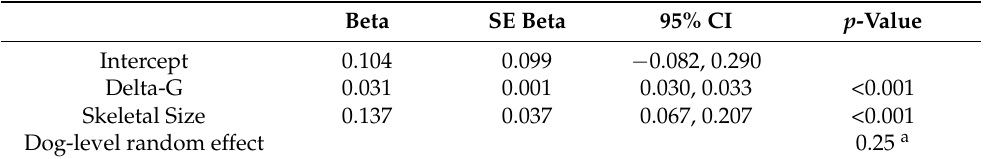
Table 2. Results from a mixed-effects linear regression model predicting speed with repeat measure- ments in individual dog accounted for with an intercept-only random effect.